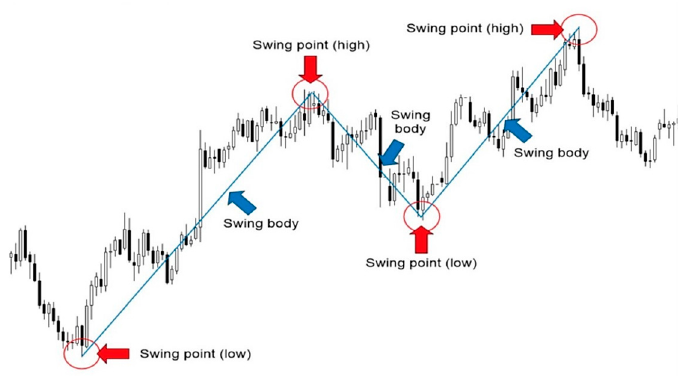
Figure 2. The basic term of Swing trading.